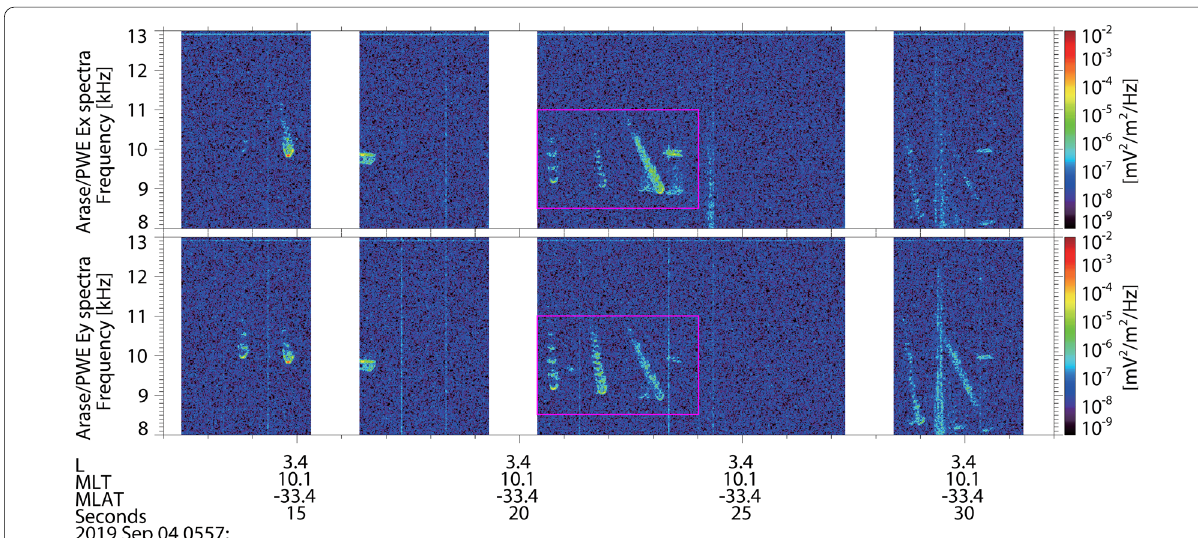
Fig. 3 Electric field observations from the PWE/WFC instrument aboard Arase. The two panels correspond to the two electric field components aligned with the WPT axes shown in Fig. 1B. These spectral data were derived from time‑series waveform data and employed a frequency resolution of 16 Hz. The magenta boxes indicate the strongest signal received during the